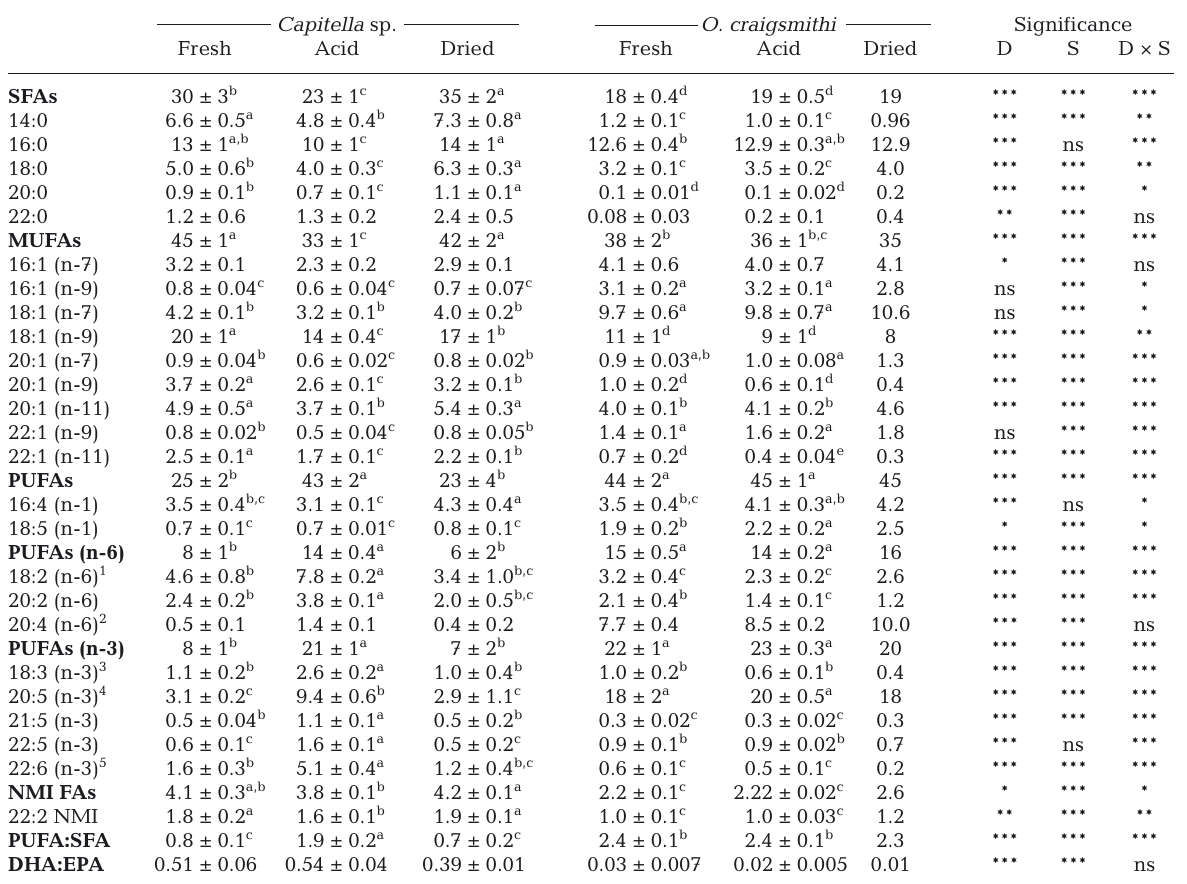
Table 4. FA composition (% of total FAs, all defined in Table 3) of the 2 polychaete species ( Capitella sp. and Ophryotrocha craigsmithi ) fed with the 3 different diets (defined in Table 1). Values are given as means ± SD (n = 4 tanks treatment −1 , except for O. craigsmithi [dried], where n = 2). Significance as in Table 1. D: diet; S: